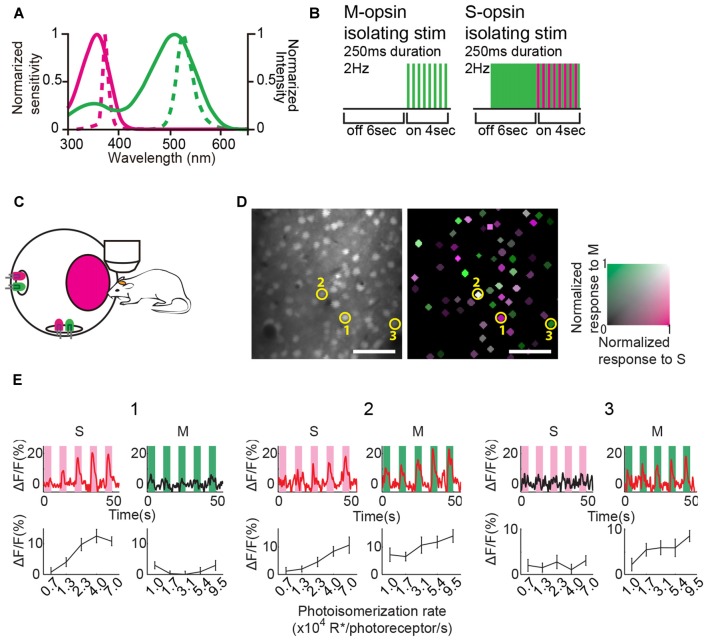
Color stimulation design and responses of representative V1 neurons to color stimulation. (A) Normalized spectral sensitivity of mouse S and M opsins (solid magenta and green lines, respectively), and power spectra of light emission diodes (LEDs) (broken magenta and green lines represent UV and green LEDs, respectively). (B) Schematics of color stimulation protocols. Color stimulation was presented for 4 s after a 6 s blank period. LEDs flashed for 250 ms at 2 Hz during the stimulation. In the S-opsin isolating stimulation trial, the green light was presented before UV stimulation, and then the intensity of the green light was weakened when the UV light flashed so that M-opsin activity was maintained before and during stimulation. (C) Schematic of color stimulation apparatus. An integrating sphere containing LEDs was mounted 3 cm away from the mouse eye to provide uniform color stimulation. LEDs were covered by reflecting plate (not drawn) so that LED’s light did not directly reach the mouse eye. (D) (Left) An example of two-photon fluorescence image. Neurons were labeled with Oregon Green 488 BAPTA-1 AM (OGB-1 AM). (Right) Neuronal responses to color stimulations represented by the green–magenta color code (green, M response; magenta, S response). Colored neurons significantly responded to at least one of the two color stimulations. The color code indicates the response magnitude normalized to the maximal response to S- or M-opsin isolating stimulation within the imaging field. Scale bars = 50 μm. (E) Ca2+-signal time courses (top row) and mean ΔF/F (bottom row) of three representative neurons indicated by the circle and number in (D). Time courses were generated by averaging the data of 15 trials. Magenta and green shades illustrate stimulation periods. Stimulation intensity was varied in five steps. The red lines indicating the time courses represent a statistically significant response. Error bars indicate standard error of mean (SEM).